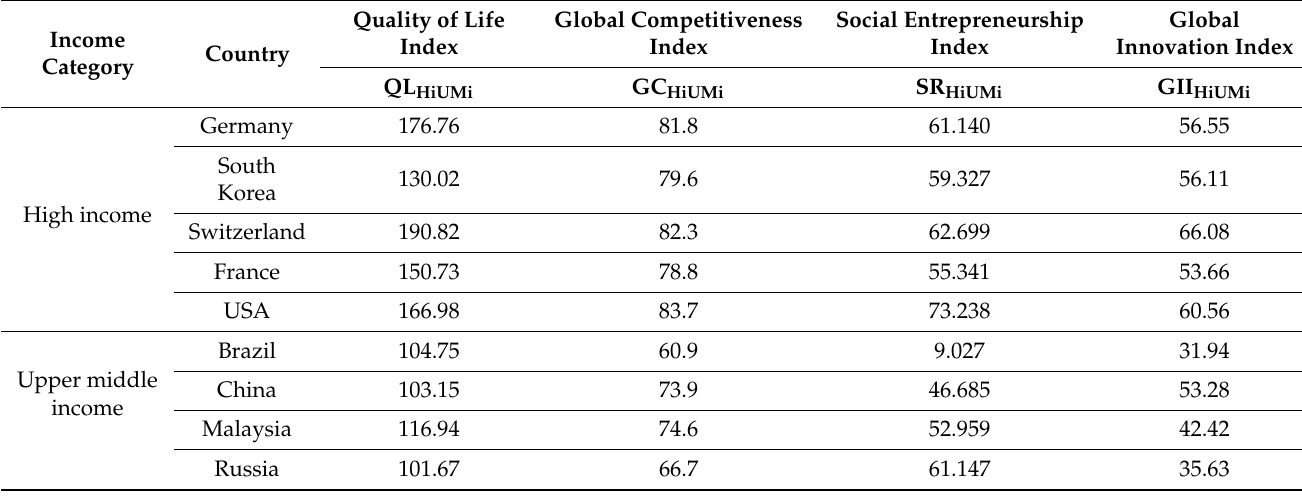
2nd: dependence of competitiveness and corporate responsibility (separately) on the Global Innovation Index (according to WIPO (2021)). The arrays of data for the research on both samples of countries are given in Tables 1 and 2. Table 1. Innovations, orientation at the consumer market: competitiveness and corporate responsibility in countries with high income and upper middle income in 2021, points 0–100.